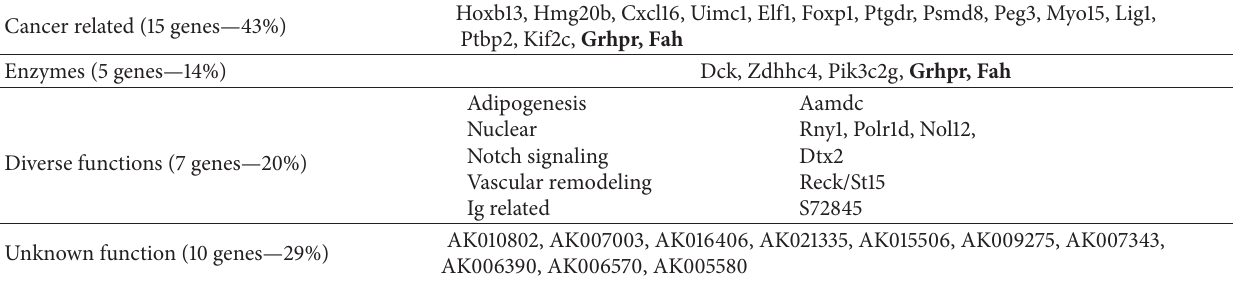
Table 3: Group analysis of genes that decrease their expression in 3T3-L1 adipocytes by alliin pretreatment and after LPS stimuli. Cancer related (15